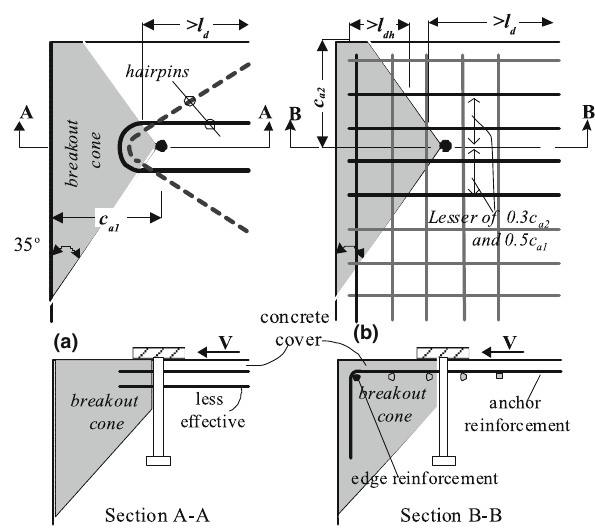
Fig. 1 Anchor reinforcement for anchors in shear in ACI 318-14. a Hairpin anchor reinforcement and b surface reinforcement with edge